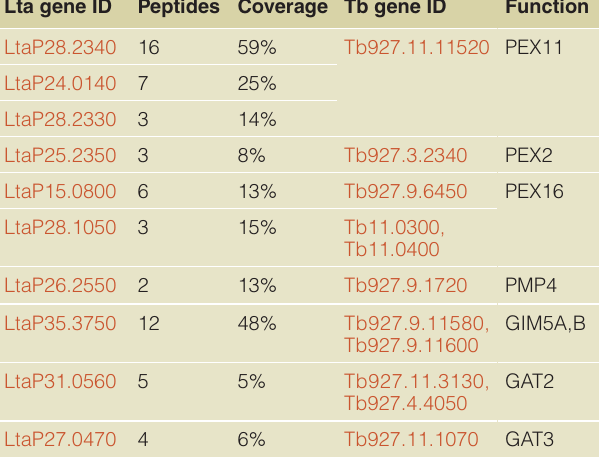
Table 1. Known proteins of the glycosomal membrane. This list includes all mass-spectrometry-detected glycosomal membrane